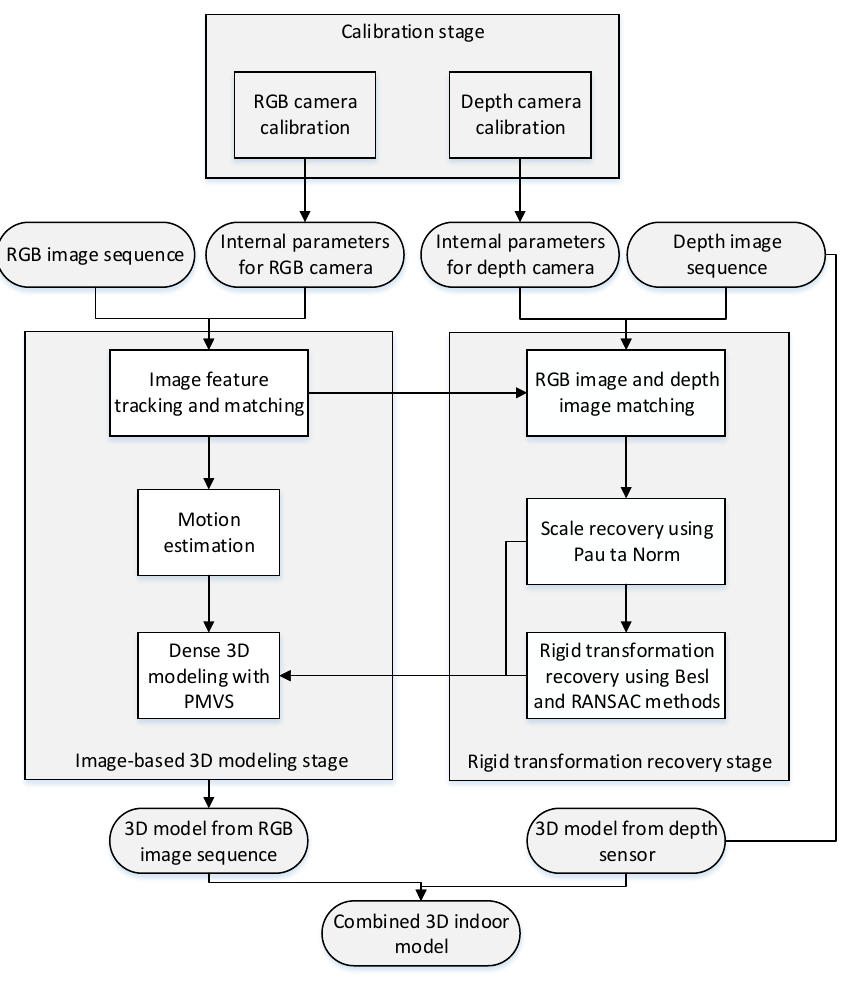
Figure 2. Flowchart of the enhanced RGB-D mapping